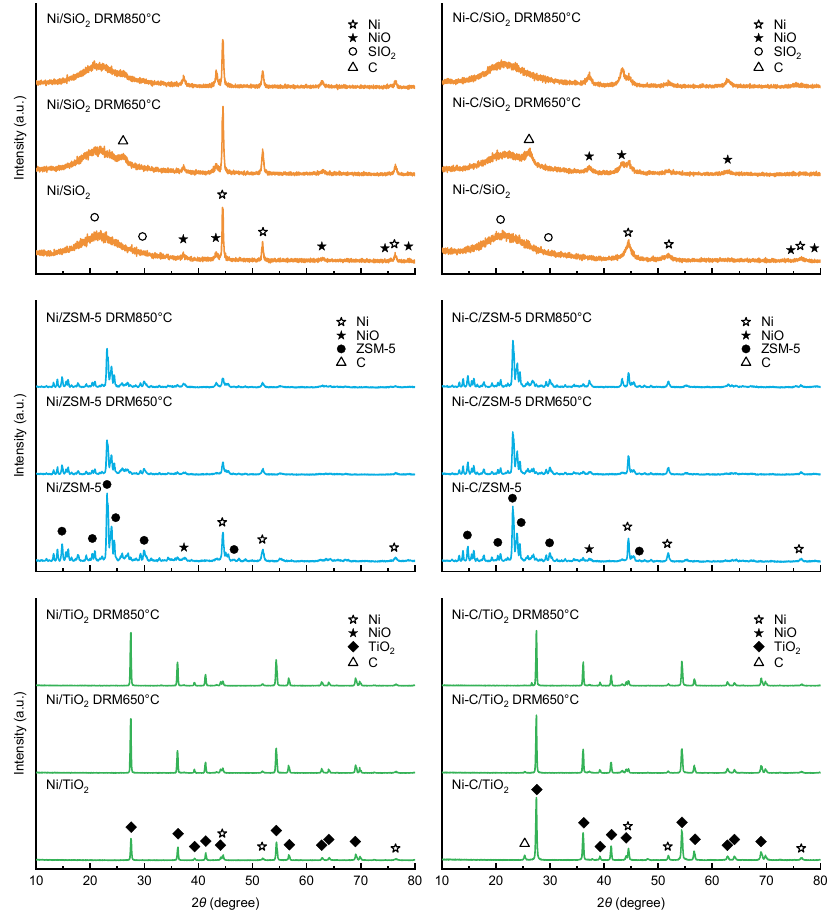
Figure 5. XRD di ff raction patterns of examined